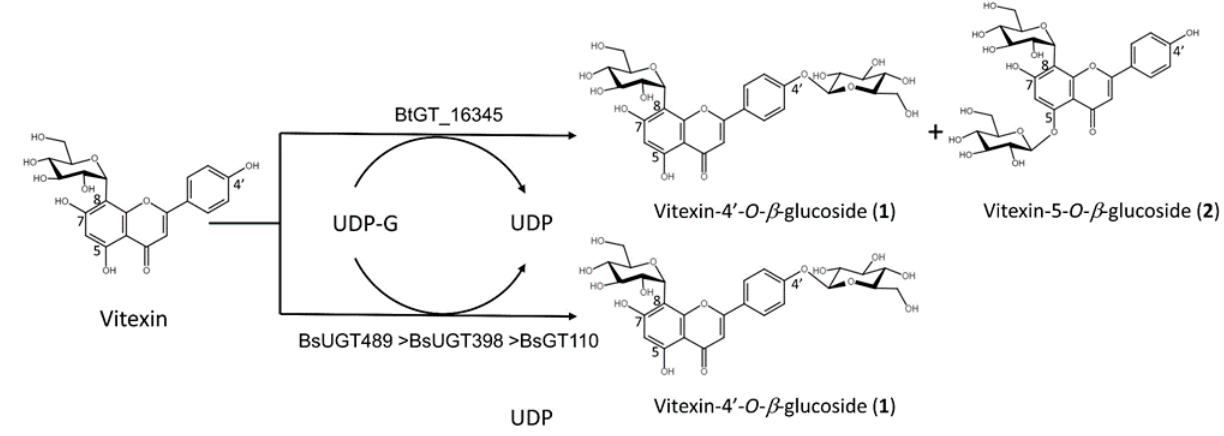
Figure 3. Biotransformation process of vitexin by Bacillus GTs.